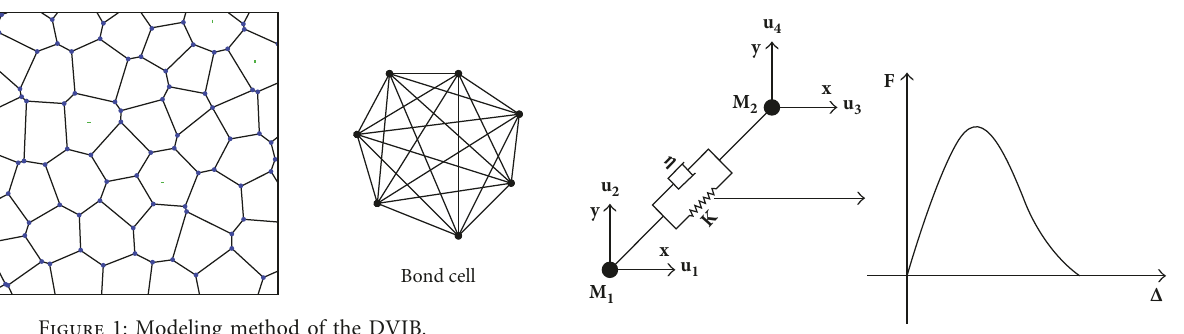
Figure 1: Modeling method of the DVIB.